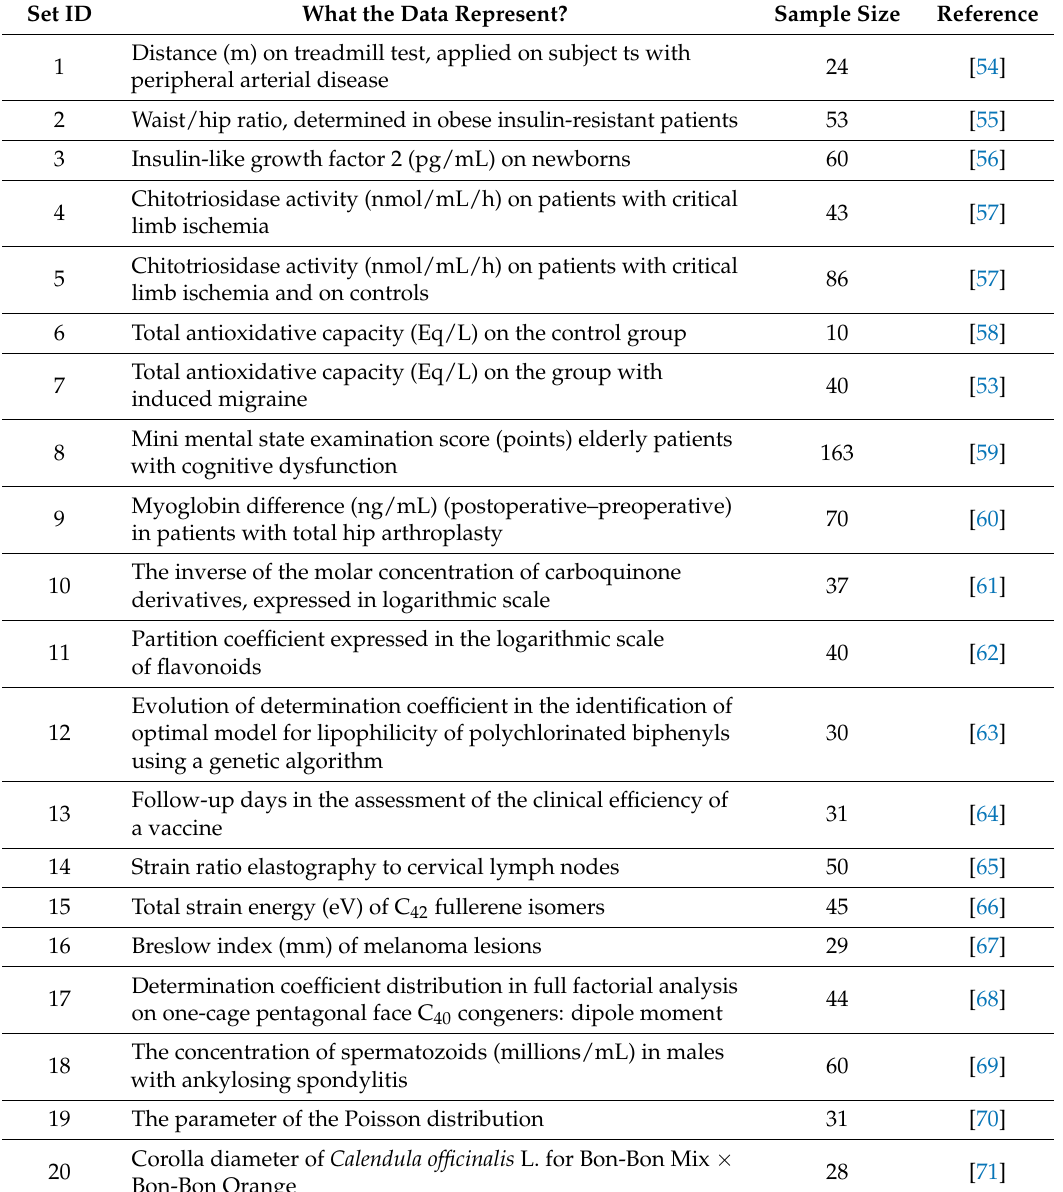
Table 9. Characteristics of the investigated